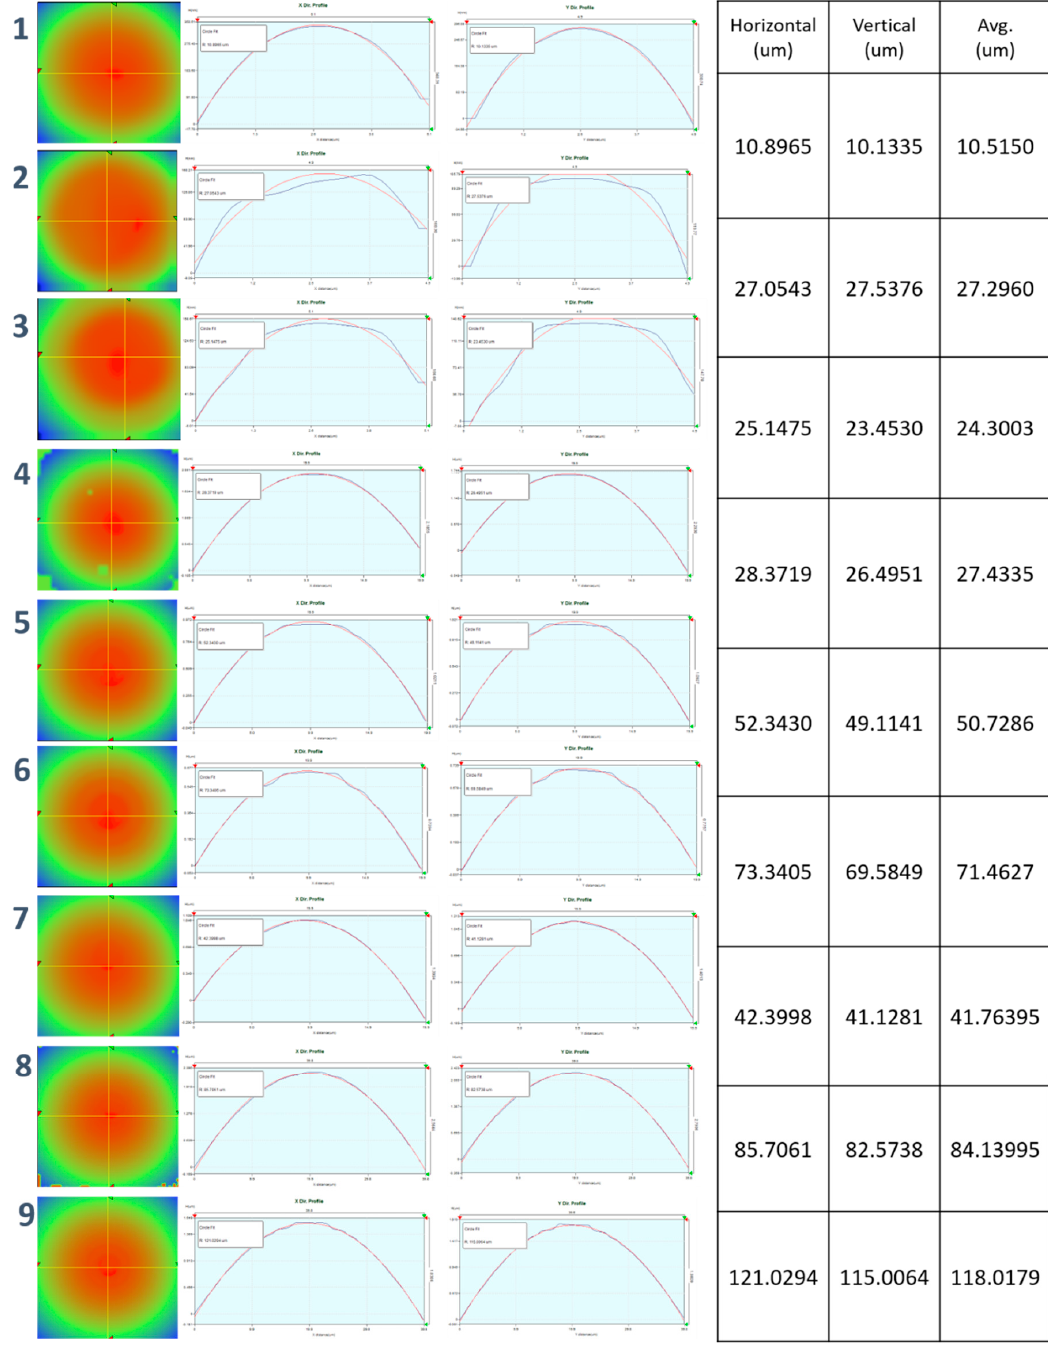
Figure A16. ROC measurement data for 4th WSM replica (PDMS).